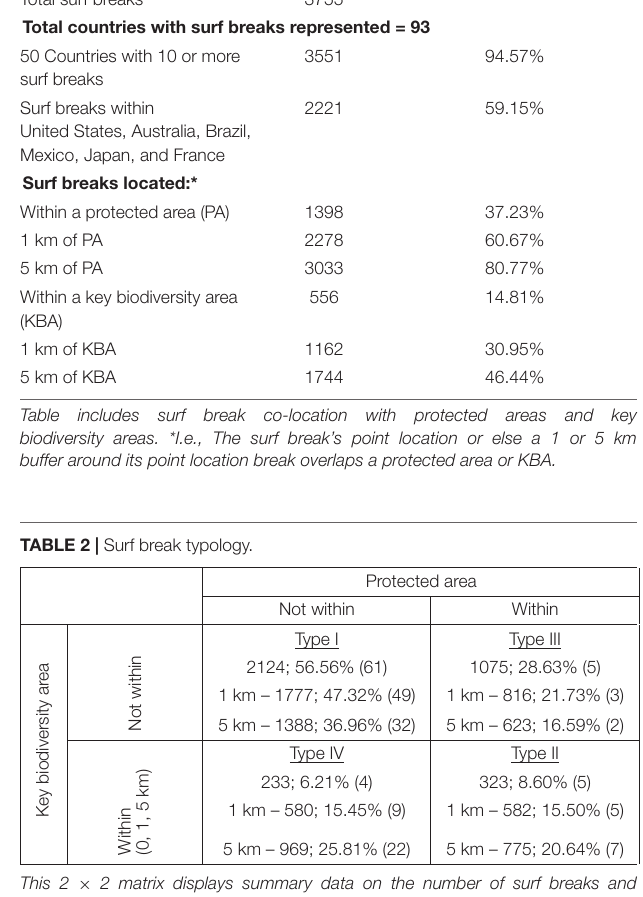
TABLE 1 | Summary location data.